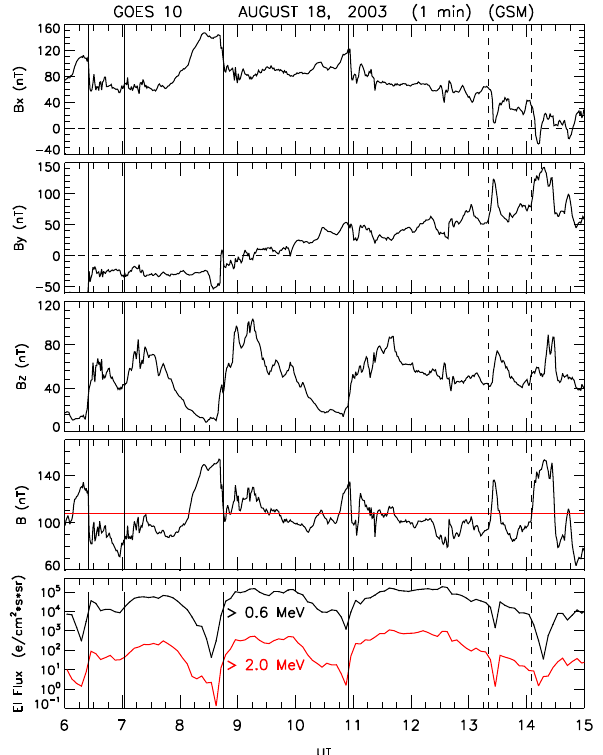
Figure 4. GOES-10 data obtained during the interval 06:00– 15:00UT. From top to bottom the panels show X , Y , and Z compo- nents of the magnetic field; the field magnitude; and the energetic differential electron fluxes in two energy regimes. Magnetic field dipolarizations ( 1B x < 0; 1B z > 0), current disruptions ( 1B < 0), and particle flux enhancements (sawtooth events) at 06:25, 08:45 and 10:55UT are marked by vertical guidelines. A similar but weaker event (see particle fluxes) at 07:02UT is also marked. The red line in the fourth panel gives the strength of the dipolar field. Magnetic field compression events at 13:20 and 14:05UT are also marked.